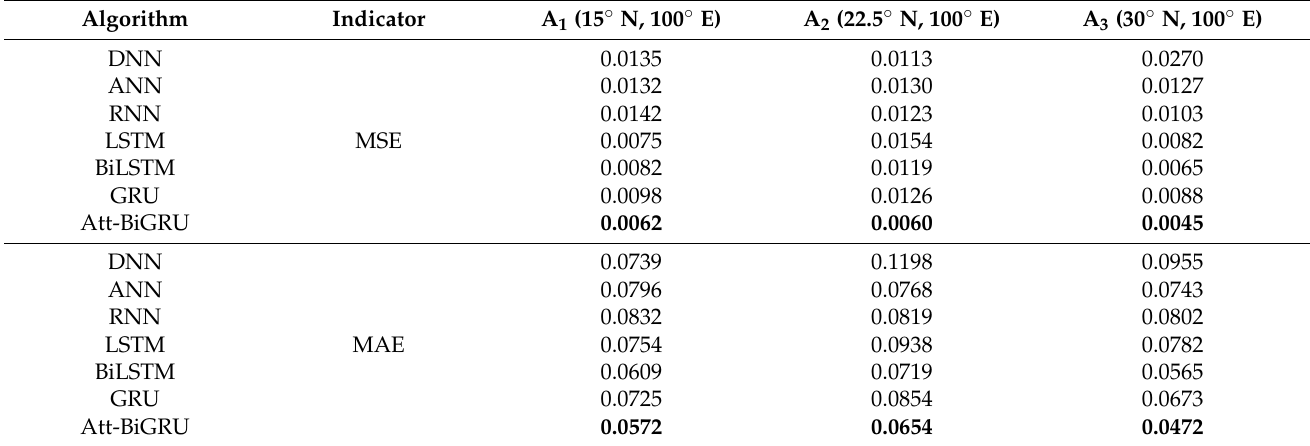
Table 6. Comparison of five methods in three low latitude